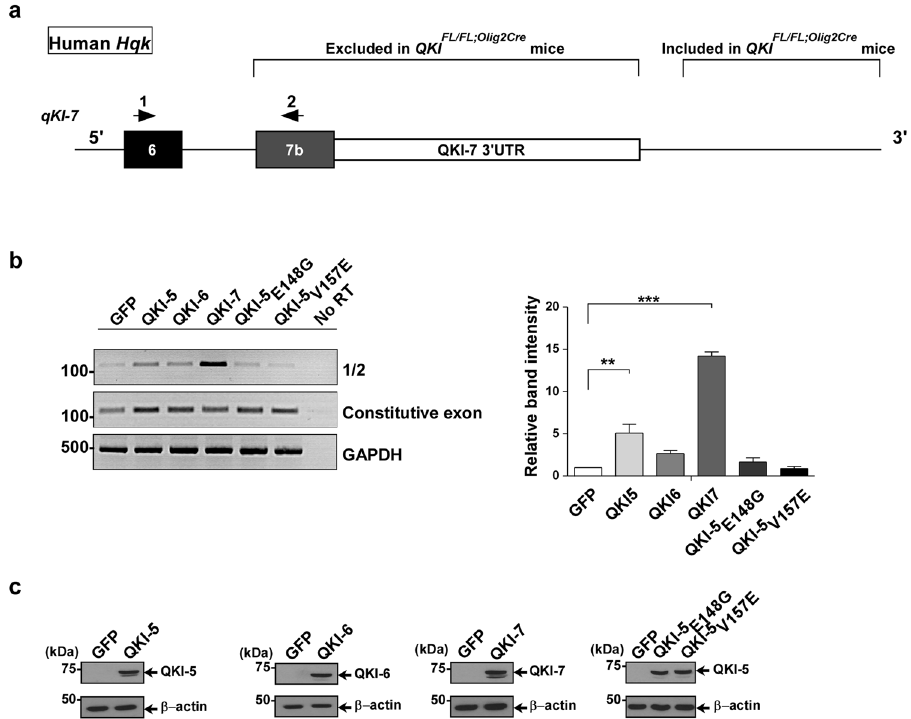
Figure 7. QKI-5 regulates self-splicing in vitro in human cells. ( a ) A schematic of the 3 ′ -UTR of human Hqk gene. Arrows indicate location of primers used for RT-PCR/splicing analysis. ( b ) (Left) HEK293T cells were transfected with expression vectors encoding green fluorescent protein (GFP) alone or expression vectors for GFP-QKI-5, -QKI-6, -QKI-7, -QKI-5:V157E or -QKI-5:E148G. Total RNA was isolated 72 h later and analyzed by RT-PCR (n = 3). The pixel densities of PCR bands from 3 independent transfections were quantified using ImageJ software, normalized over Hqk constitutive exon 1 and represented as mean ± SEM (One-way ANOVA, ** p < 0.01, *** p < 0.001). ( c ) Protein expression of transfected plasmids in HEK293T cells is determined by immunoblotting using the indicated QKI antibodies or β -actin antibody for equivalent loading. The molecular mass markers are shown on the left in kDa and the migration of the GFP-QKI isoforms indicated on the